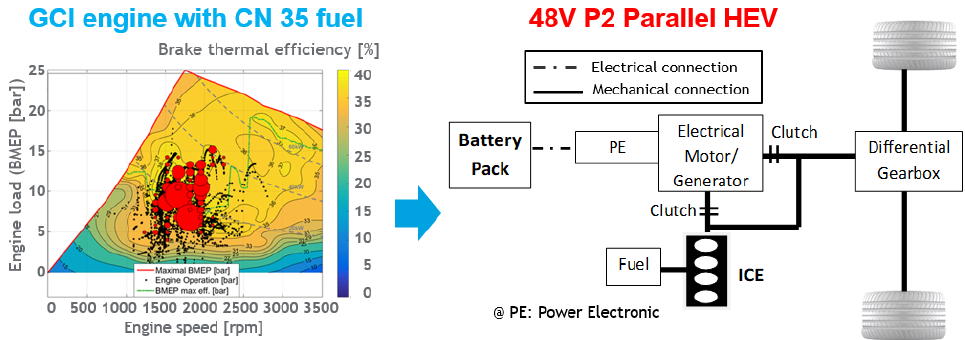
Figure 6. The coverage of the operating points of CN35 engine on cold WLTC with 48 V P2 Parallel HEV configuration.